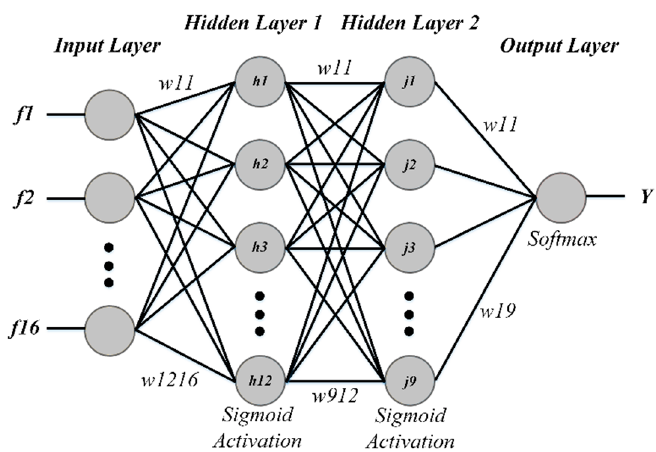
Figure 8. Architecture of an ANN model.